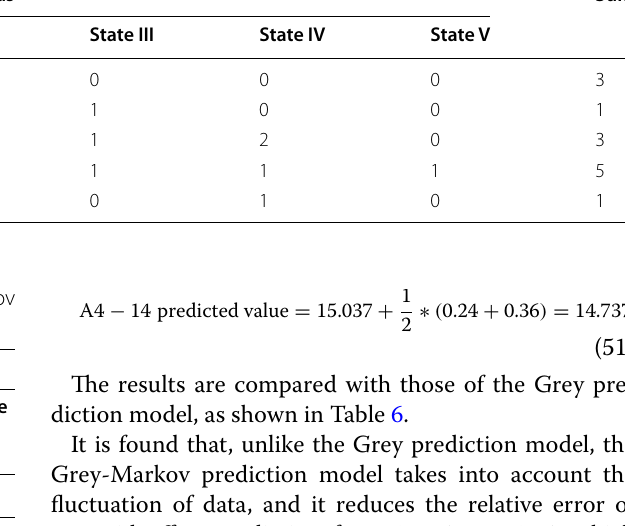
Table 5 Statistical results of state transfer of residual error P ij Next moment residual status